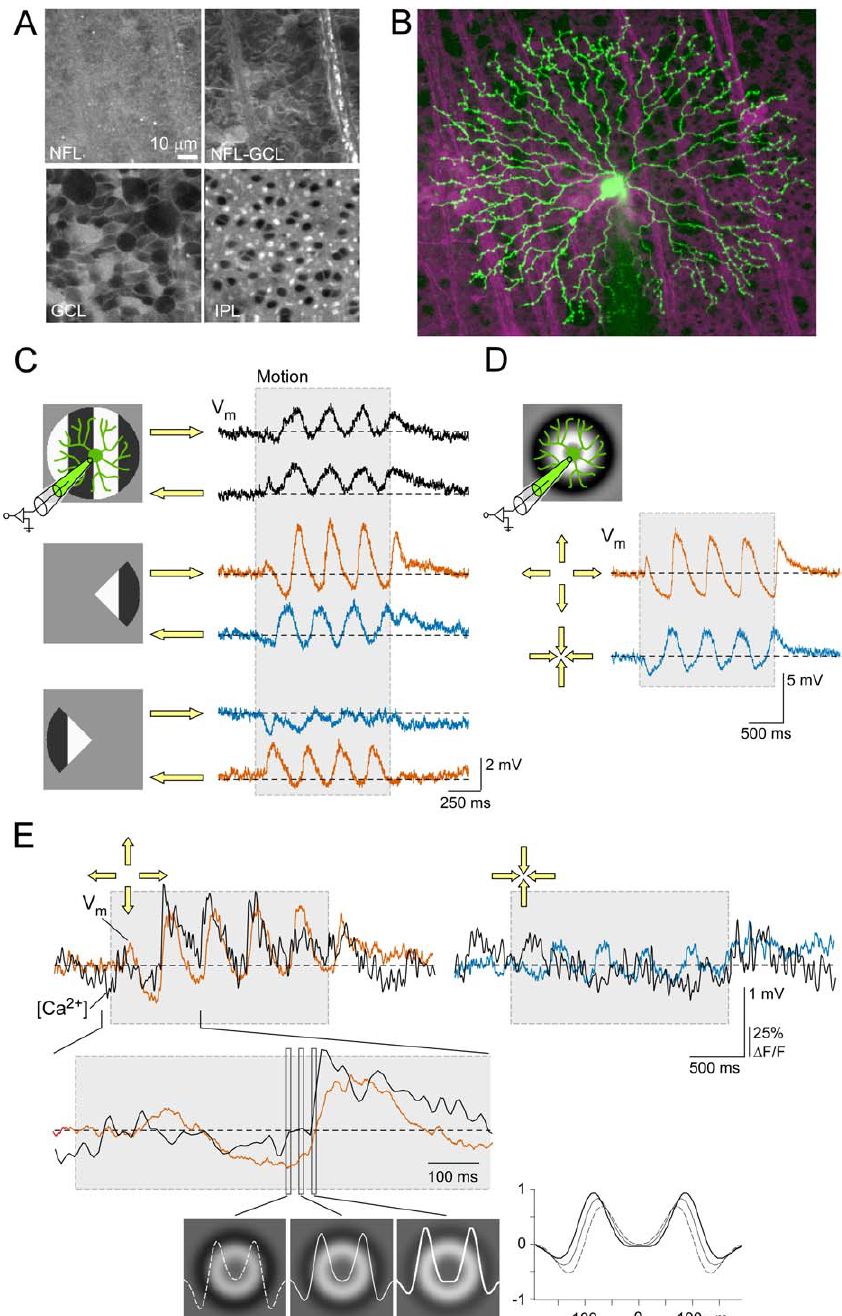
Figure 1. Voltage and Ca 2 þ Responses of Starburst Cells to Moving Gratings and Circular Waves (A) Two-photon micrographs of a living, flat-mounted retina stained with Sulforhodamine 101 (different focal planes: GCL, ganglion cell layer; IPL, inner plexiform layer; NFL, nerve fiber layer). ON (displaced) starburst amacrine somata can be identified by shape and size (center of lower left panel). (B) Cell from (A) filled with the Ca 2 þ indicator dye Oregon-Green 488 BAPTA-1 (green) via the patch electrode (shadow from below; maximum-projected image stack; magenta: sulforhodamine). (C) Voltage responses ( V m ) evoked by a bar grating (4 Hz; 72% contrast; period 192 l m) moving left or right (yellow arrows) presented to the full field or ‘‘ behind ’’ masks (gray) recorded from a different SAC. Left: stimuli and their positions relative to the cell. Right: somatic voltage (gray area indicates motion duration). (D) Voltage responses to circular wave stimulation (2 Hz; 72% contrast; period: 192 l m, see Materials and Methods for details) expanding (CF, orange) or contracting (CP, blue). (E) Simultaneous recording of somatic voltage (orange, blue) and dendritic [Ca 2 þ ] (black) to circular-wave stimulation. Below: response to CF motion at higher magnification. Gray rectangles indicate duration of stimulus presentation. Radial distribution of normalized stimulus intensity for the three frames are shown as curves on frames (white) and as overlay (plot). (C and D) show averages of three trials, (E) shows single trials; V Rest (mV): (C) (cid:2) 43, (D) (cid:2) 61, and (E) (cid:2)